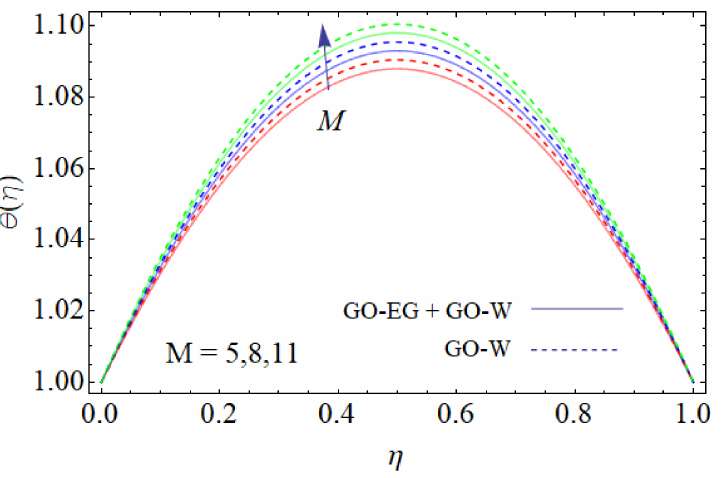
Figure 12. Influence of the Eckert number on the temperature profile.